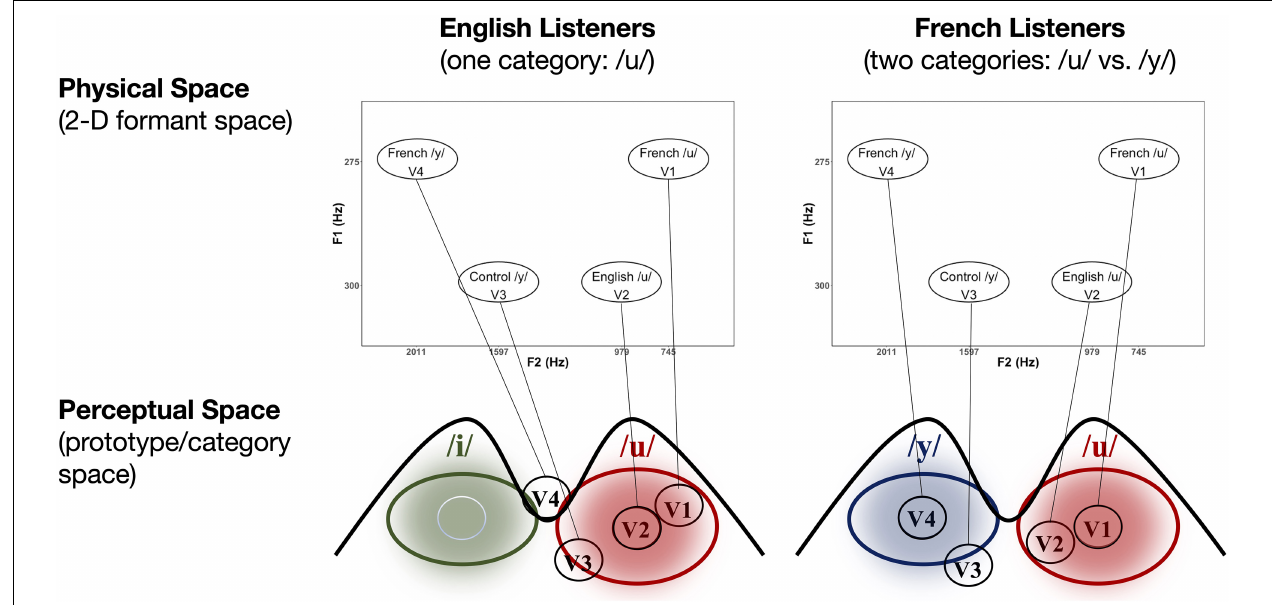
FIGURE 2 | Schematic of the hypothesized relationship between physical (2D F 1 –F 2 formant) space and perceptual (prototype/category) space in the case of the current vowel stimuli for both English ( left ) and French ( right ) listeners (see text for explanation).